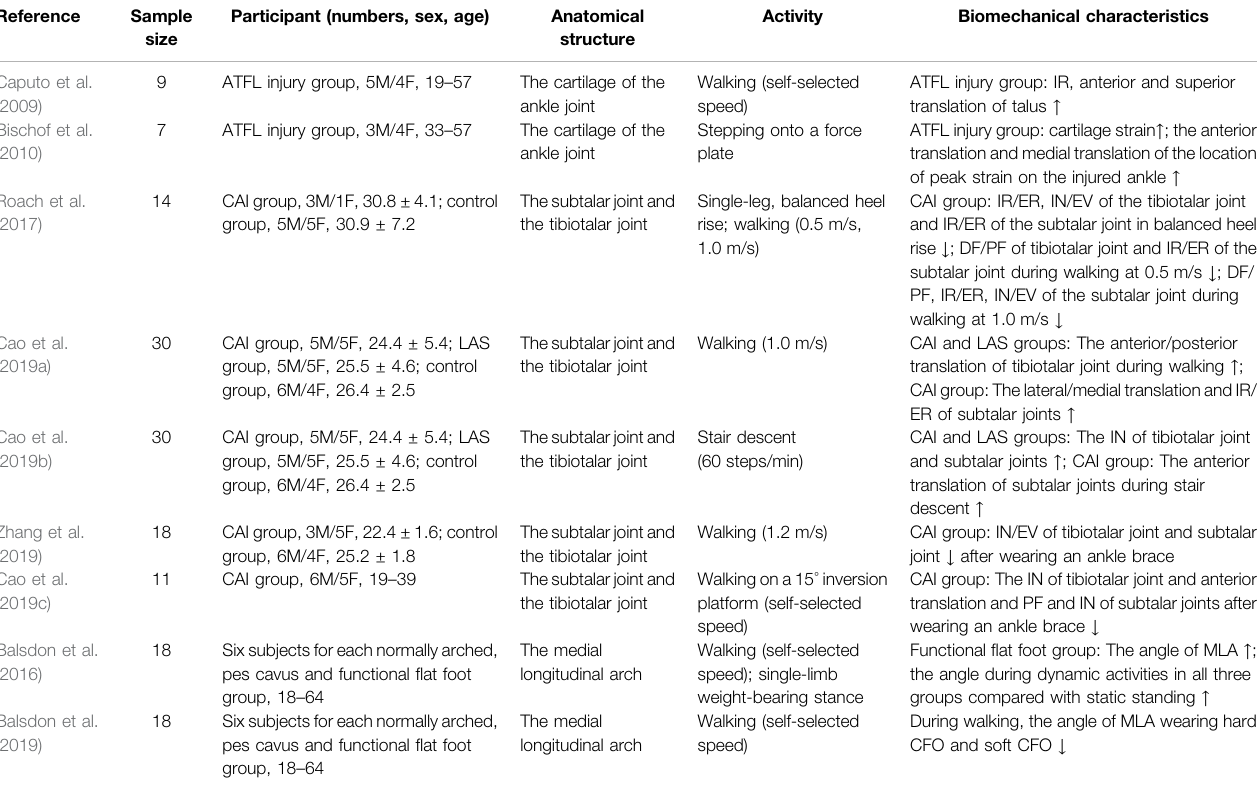
TABLE 3 | Summary of DFIS studies on pathological populations.